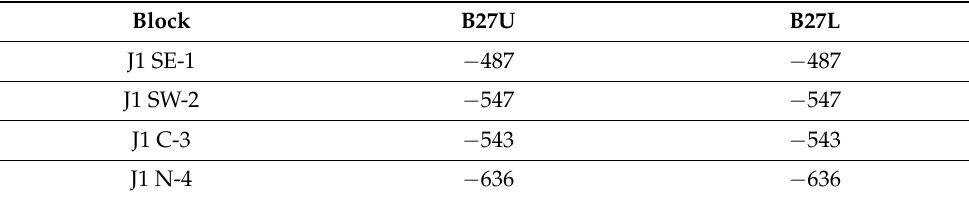
Table 3. Depths of water–oil contact (m) for the B27 reservoir.